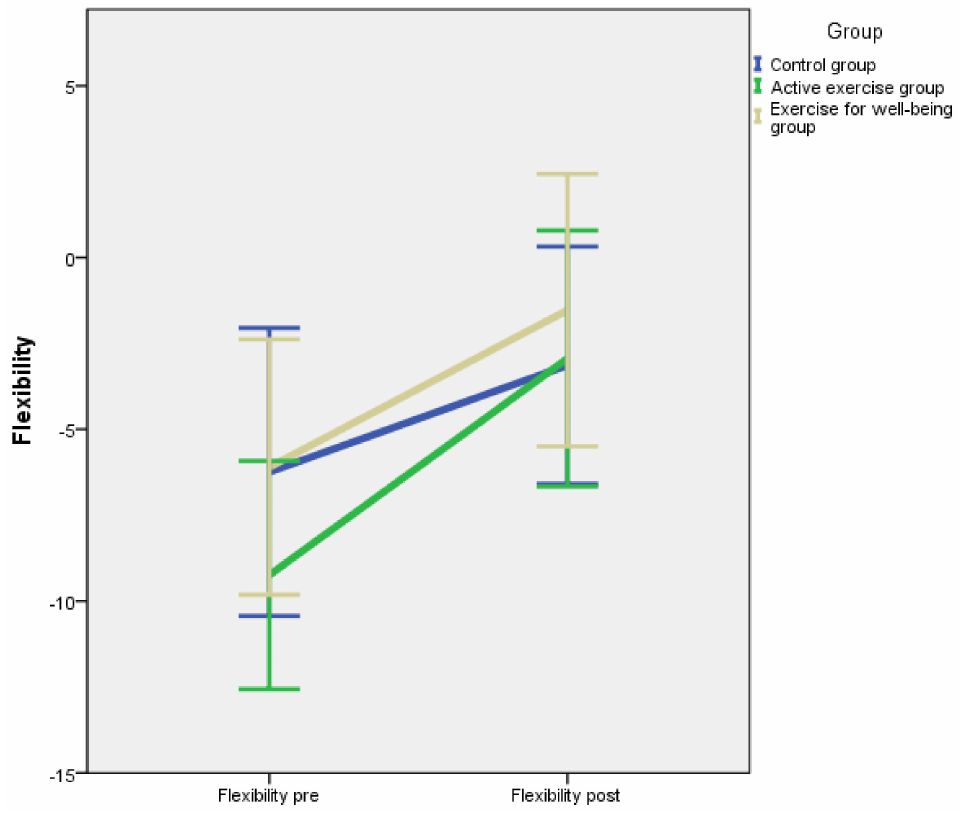
Figure 2. Changes in